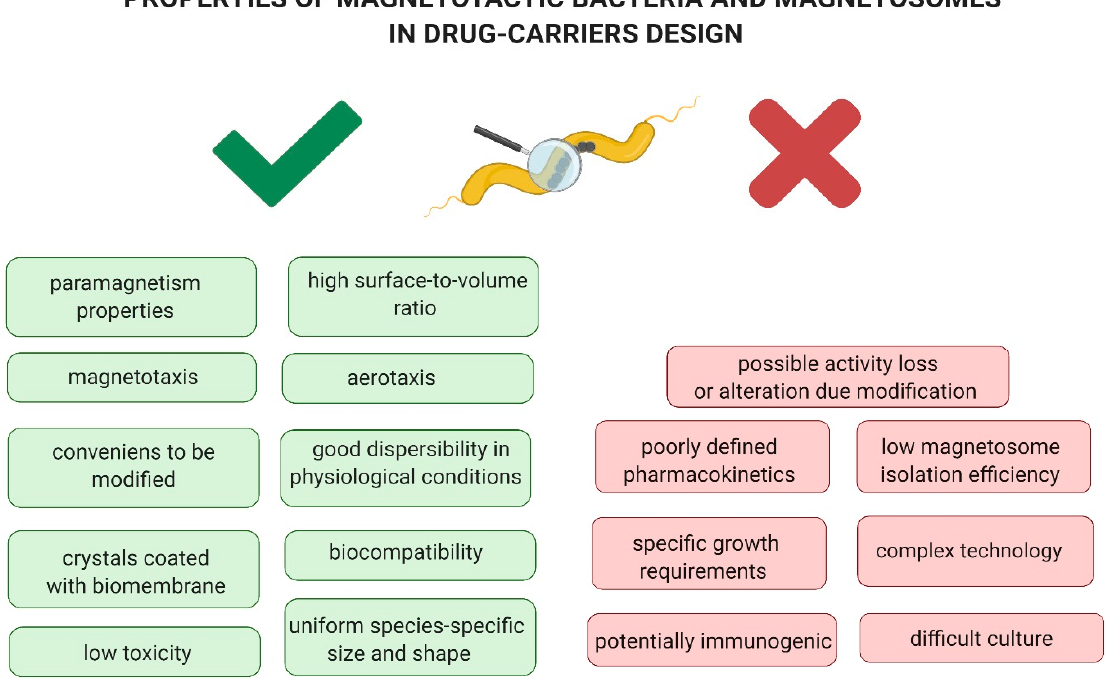
drug-carriers Figure 2. Properties of Magnetotactic bacteria and magnetosomes as advantages and disadvantages in drug-carriers design.